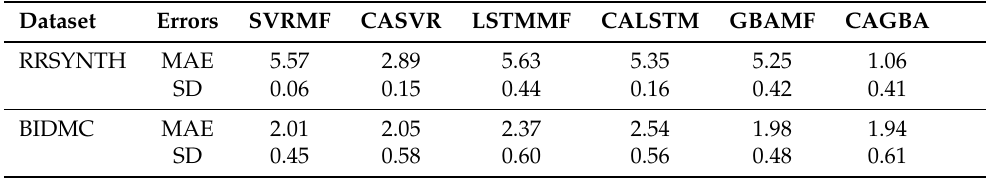
Table 3. The RR estimation results were obtained using the SVR, LSTM, and GBA models, which were calculated as the difference from the reference RR method to express it as the MAE and SD evaluation method, where the MF denotes the multiphase feature extraction and CA is the autocorrelation function-based power spectral feature